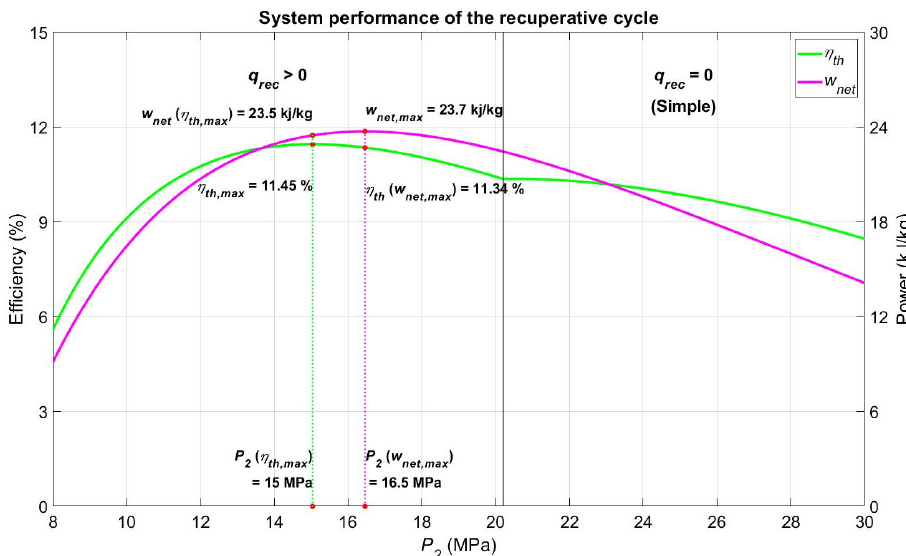
Figure 9. System performance of the recuperative cycle regarding P 2 ( T h , in = 150 ◦ C; η p = η e = 80% ).